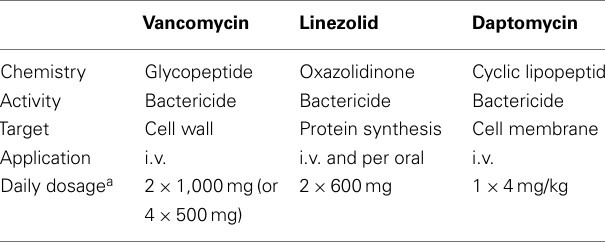
Table 1 | Basic characteristics of the MRSA active antibiotics vancomycin, linezolid, and